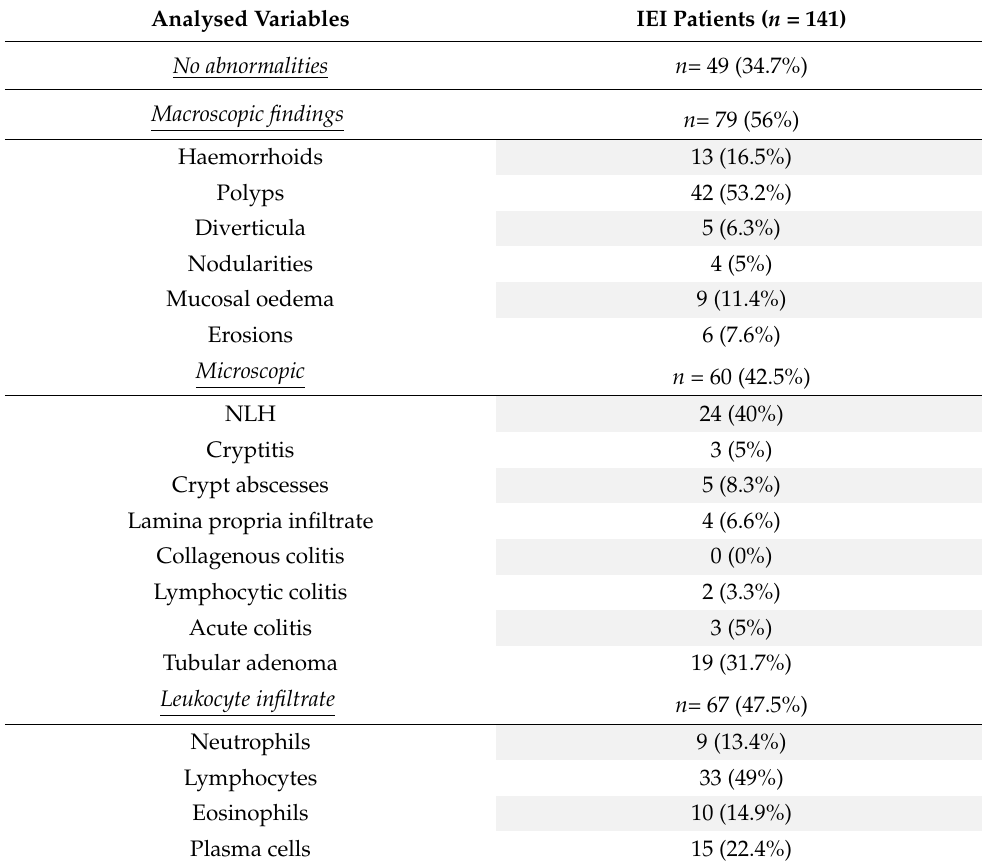
Table 4. Macroscopic and microscopic involvement of the colon in IEI patients.